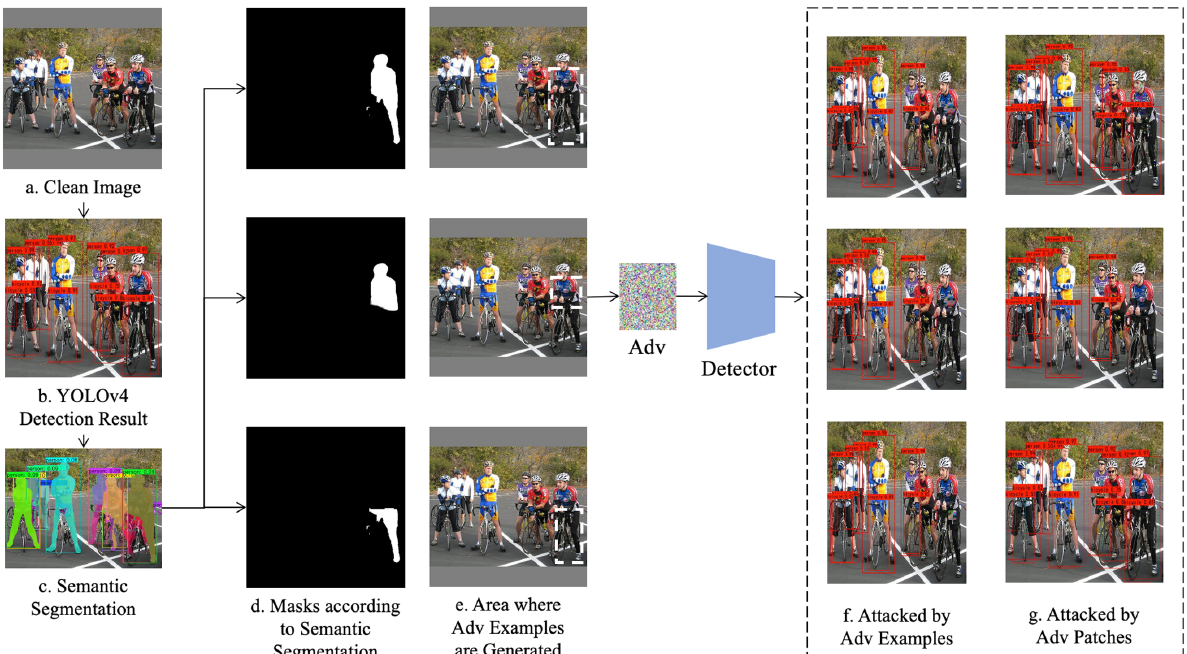
Figure 8. Ablation study of adversarial examples in different locations and sizes.